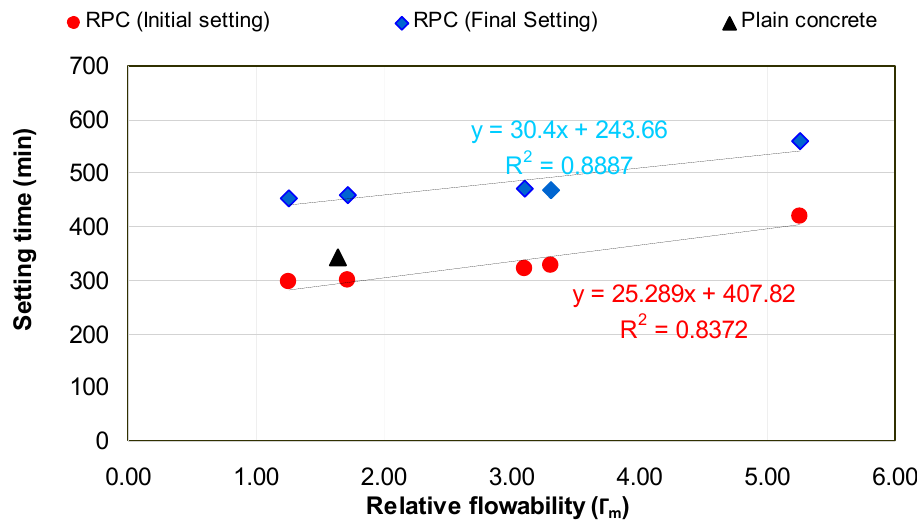
Figure 5. Relationship between setting time and flowability.